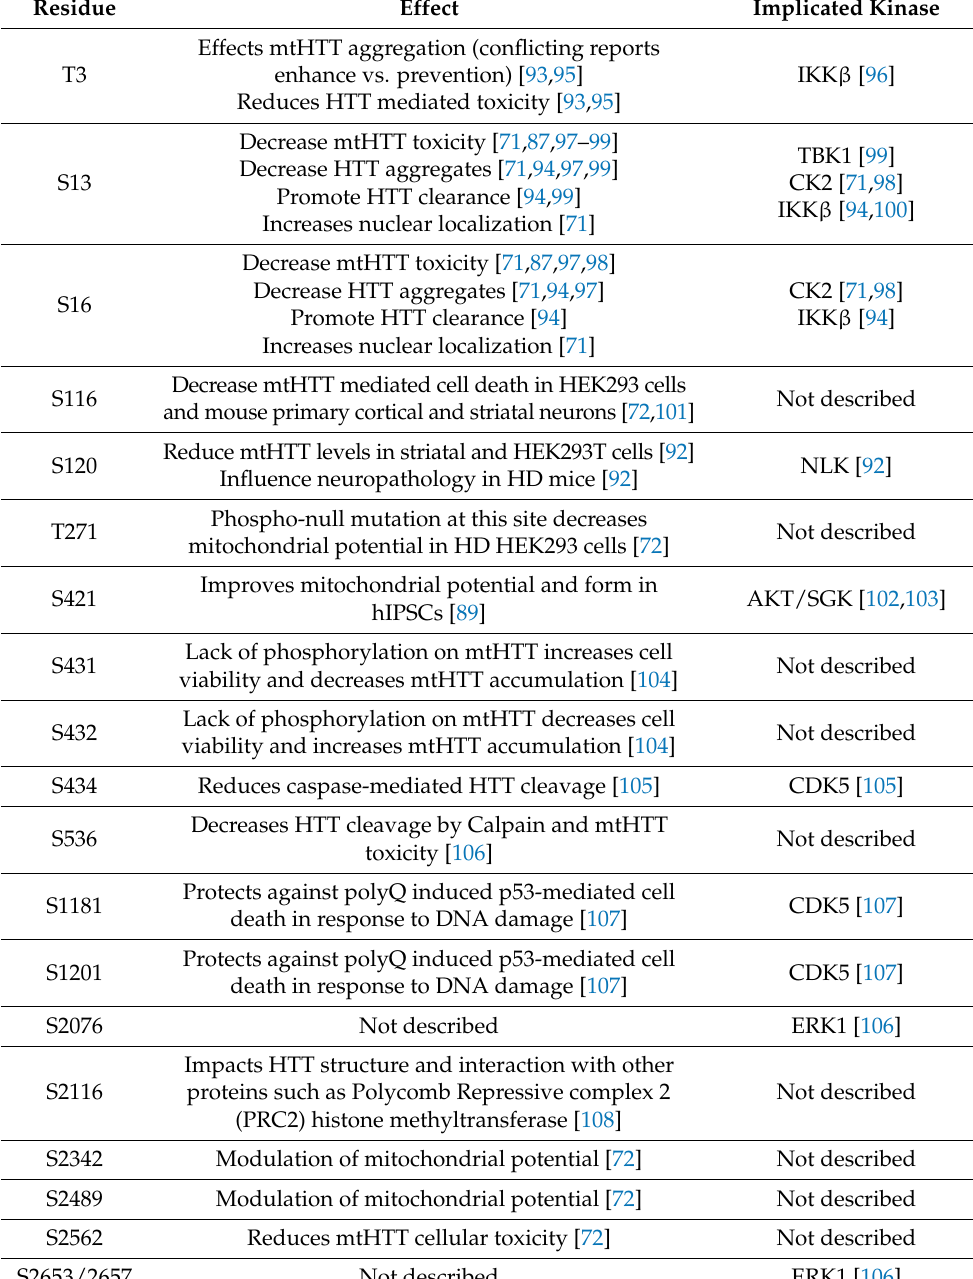
Table 2. Summary of identified HTT phosphorylation sites, their effects and described kinases